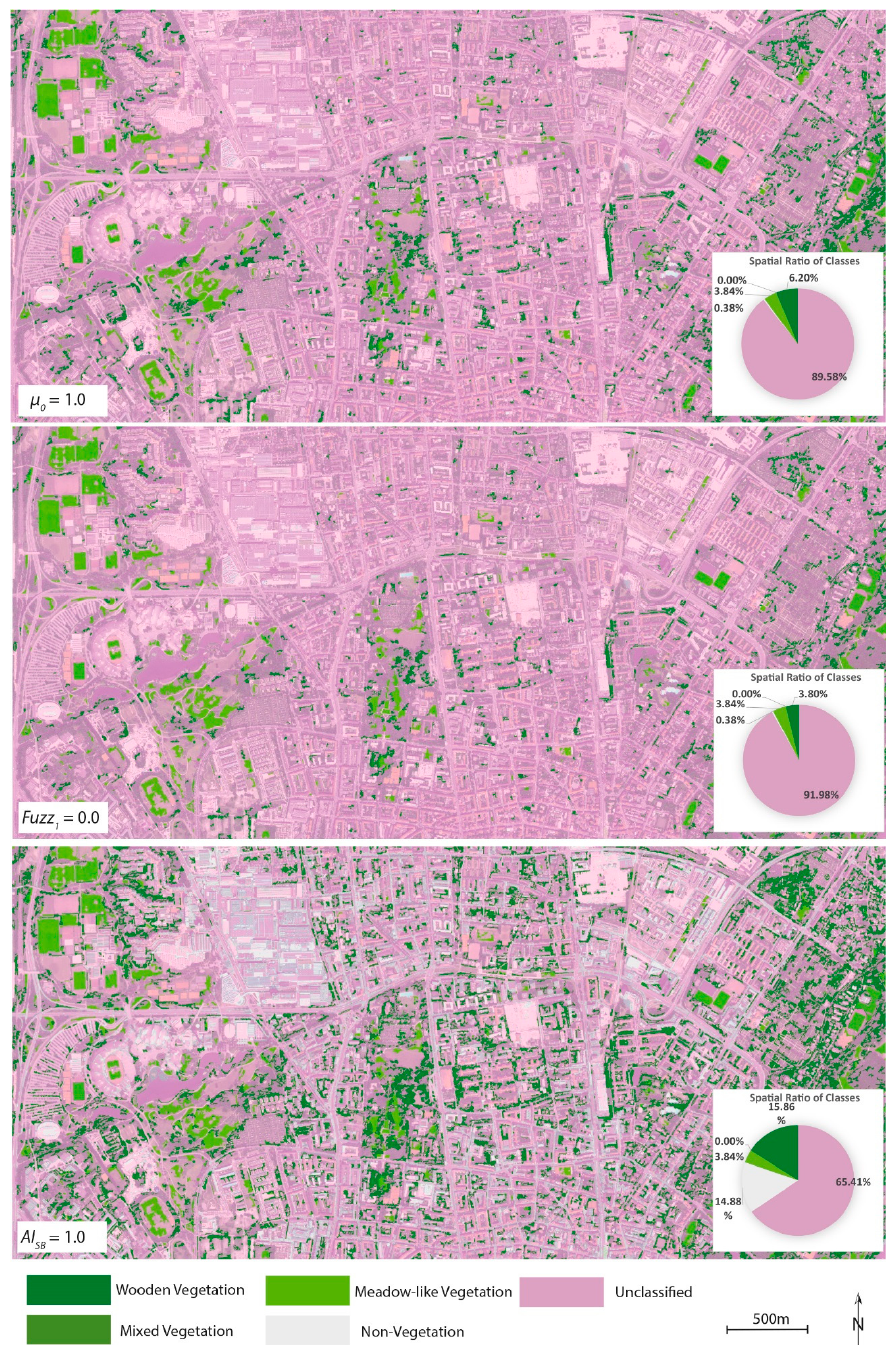
Figure 7. Crisp classification results after defuzzifying fuzzy classified objects of a WV-2 scene of Munich and their respective area coverage when applying the following single defuzzification rules: μ (cid:2868) = 1.0 , Fuzz (cid:2869) = 0.0 and AI (cid:2903)(cid:2886) = 1.0 .